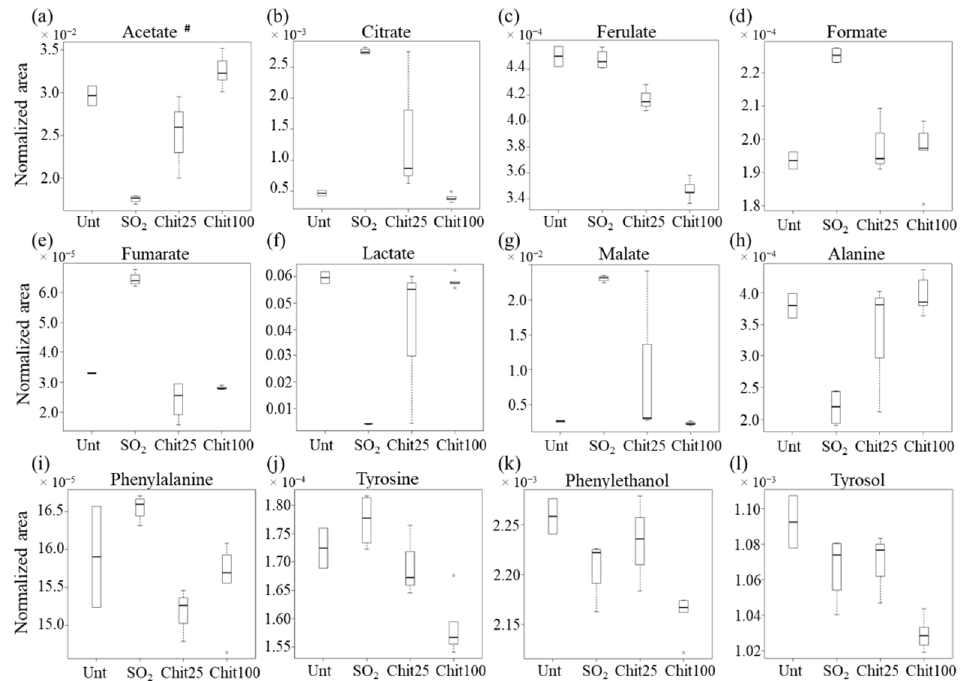
Figure 4. Boxplots illustrating the variations in the levels of organic acids, amino acids and corresponding alcohols among the different conditions: untreated (Unt, n = 2), treated with 40 mg/L SO 2 (n = 5) and treated with 25 cm 2 (n = 3) and 100 cm 2 Ch-Ge films (n = 4), Chit25 and Chit100, respectively. ( a – g ): organics acids—acetate, citrate, ferulate, formate, fumarate, lactate and malate; ( h – l ): amino acids and corresponding alcohols—alanine, phenylalanine, tyrosine, phenylethanol and tyrosol. # Acetate variation is possibly affected by residual amounts present in the films (use of acetic acid in the films’